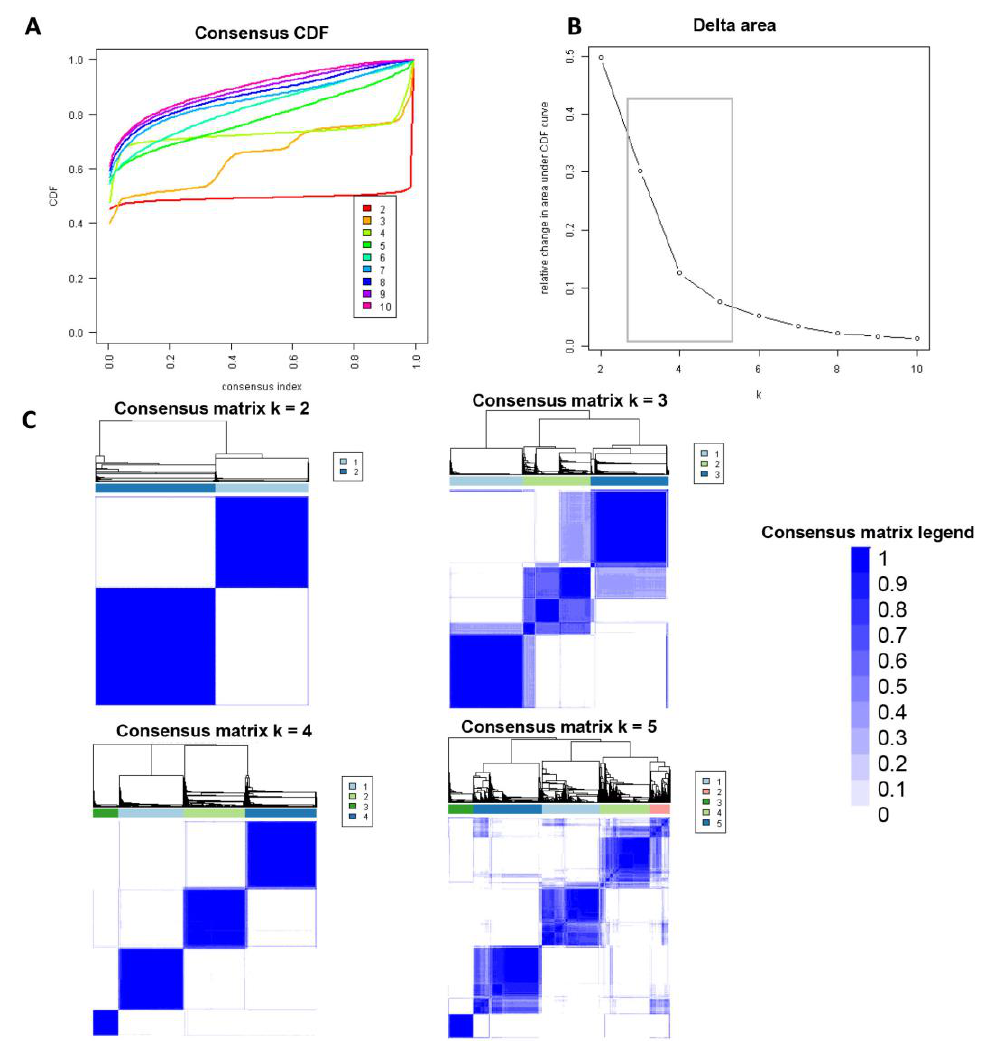
Figure 2. ( A ) CDF plot demonstrating consensus distributions for each cluster (k); ( B ) Delta area plot representing the relative changes in the area under the CDF curve. ( C ) Consensus matrix heat map displaying consensus values on a white to blue color scale of each cluster.